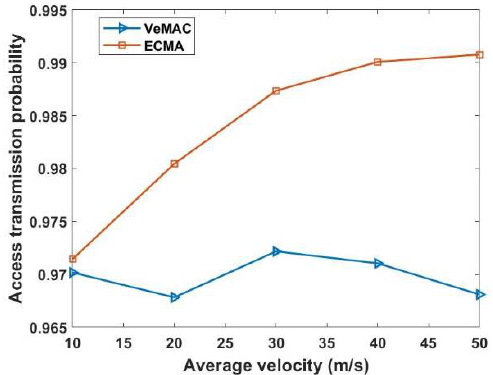
Figure 11. Successful access transmission probability versus average velocity .